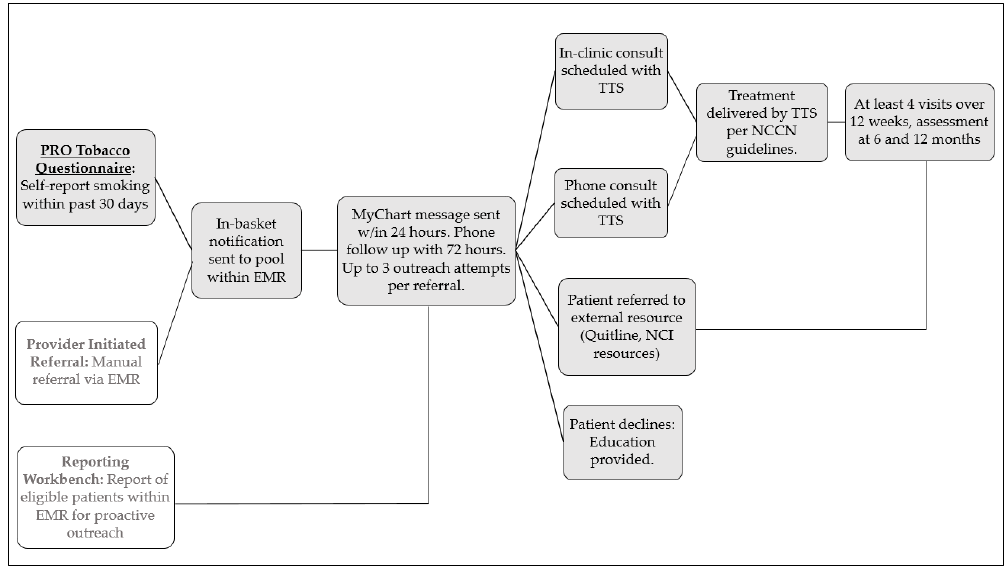
Figure 4. The workflow of the tobacco cessation program from smoker identification to treatment engagement and delivery.